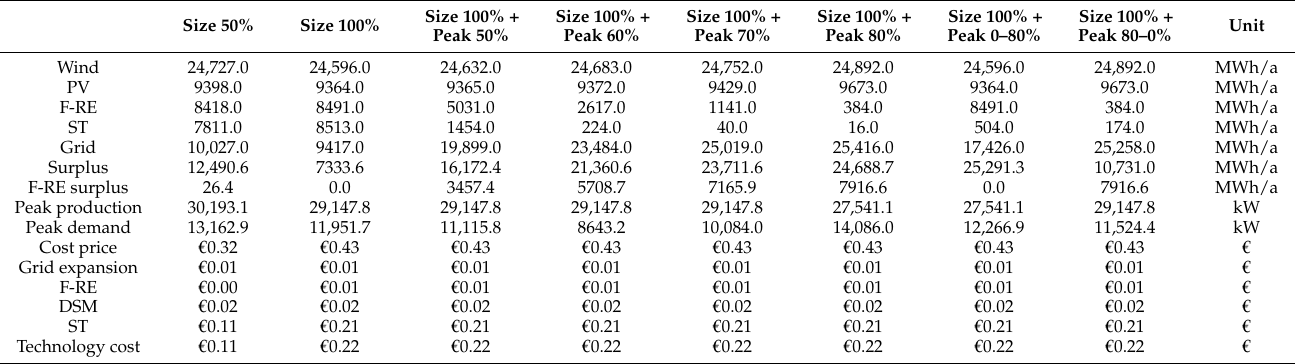
Table A19. Results from the balancing technology scenarios including peak